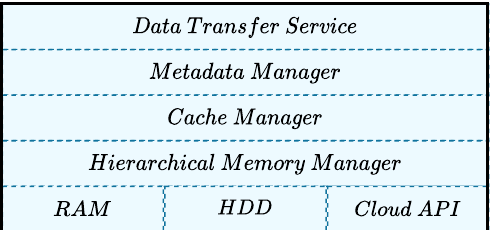
Figure 1. Stack representation of a data container for the efficient management of